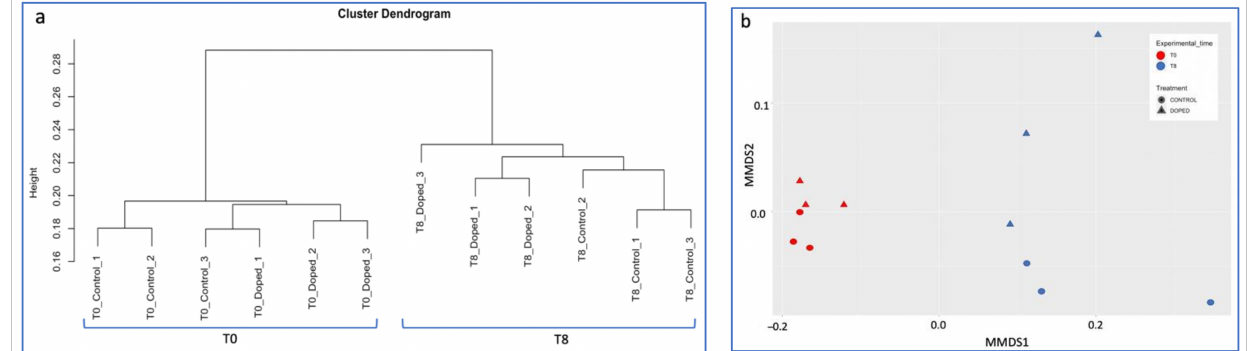
Figure 5. ( a ) Cluster dendrogram analysis of Hellinger transformation using the Bray–Curtis dissimilarity matrix and ( b ) Nonmetric Multidimensional Scaling (NMDS) analysis of data transformed by “phyloseq” function and based on Bray–Curtis dissimilarity matrix to ordinate microbial community composition of the different CWs systems, irrigated for eight weeks with Ribeira de Joane water not doped (control) or doped with NP and OP. Samples collected at the beginning (T0) and at the end of the experiment (T8) ( n = 3). The Kruskal–Wallis test was conducted to examine the difference between microbial communities of each sample.